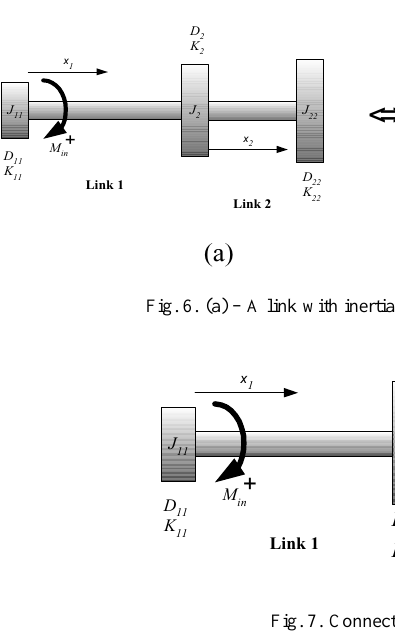
Fig. 7. Connection via damper and